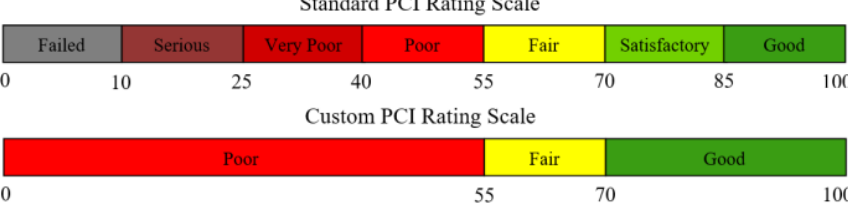
Figure 2. Pavement condition index (PCI) rating.